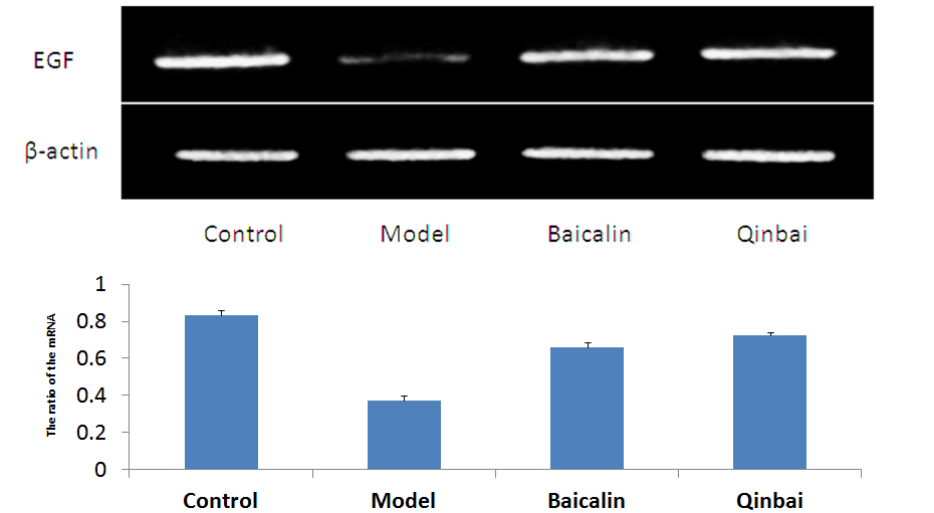
times. Data are presented as mean ± SD, p < 0.05.